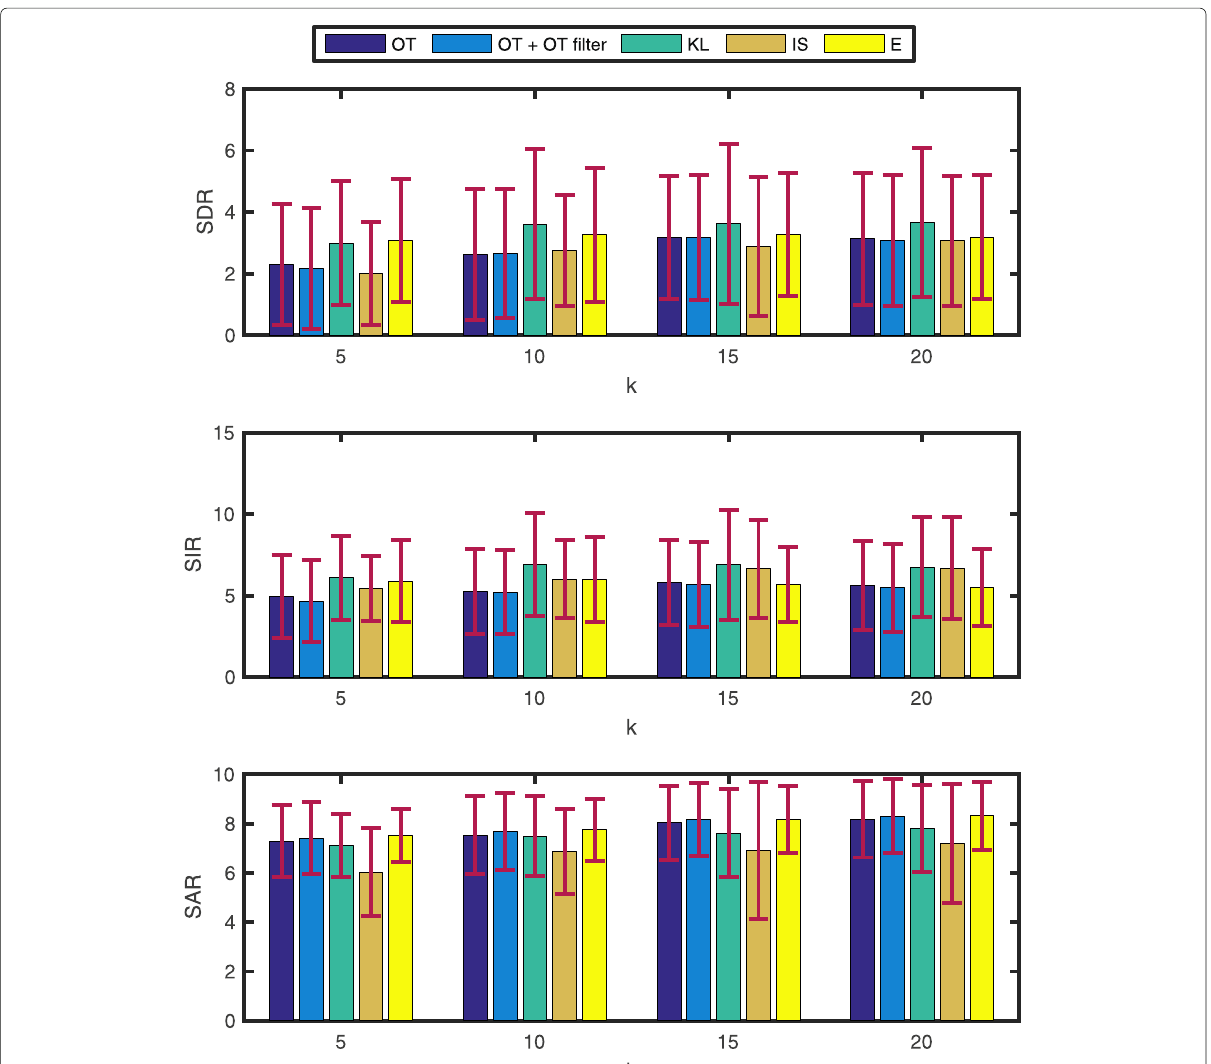
Fig. 6 Voice-voice separation score (single-domain). Average and standard deviation of SDR, SIR, and SAR scores for voice BSS, in the single-domain setting where training and testing spectrograms represent the same frequencies. The scores are for NMF with optimal transport (dark blue), optimal transport with our generalized filter (light blue), Kullback-Leibler (green), Itakura-Saito (brown), or Euclidean (yellow)